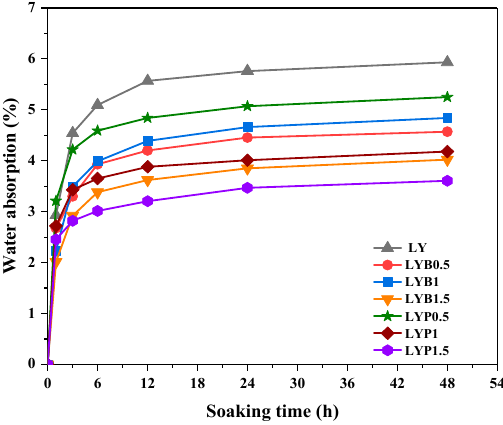
Figure 5. Water absorption of mixture groups.